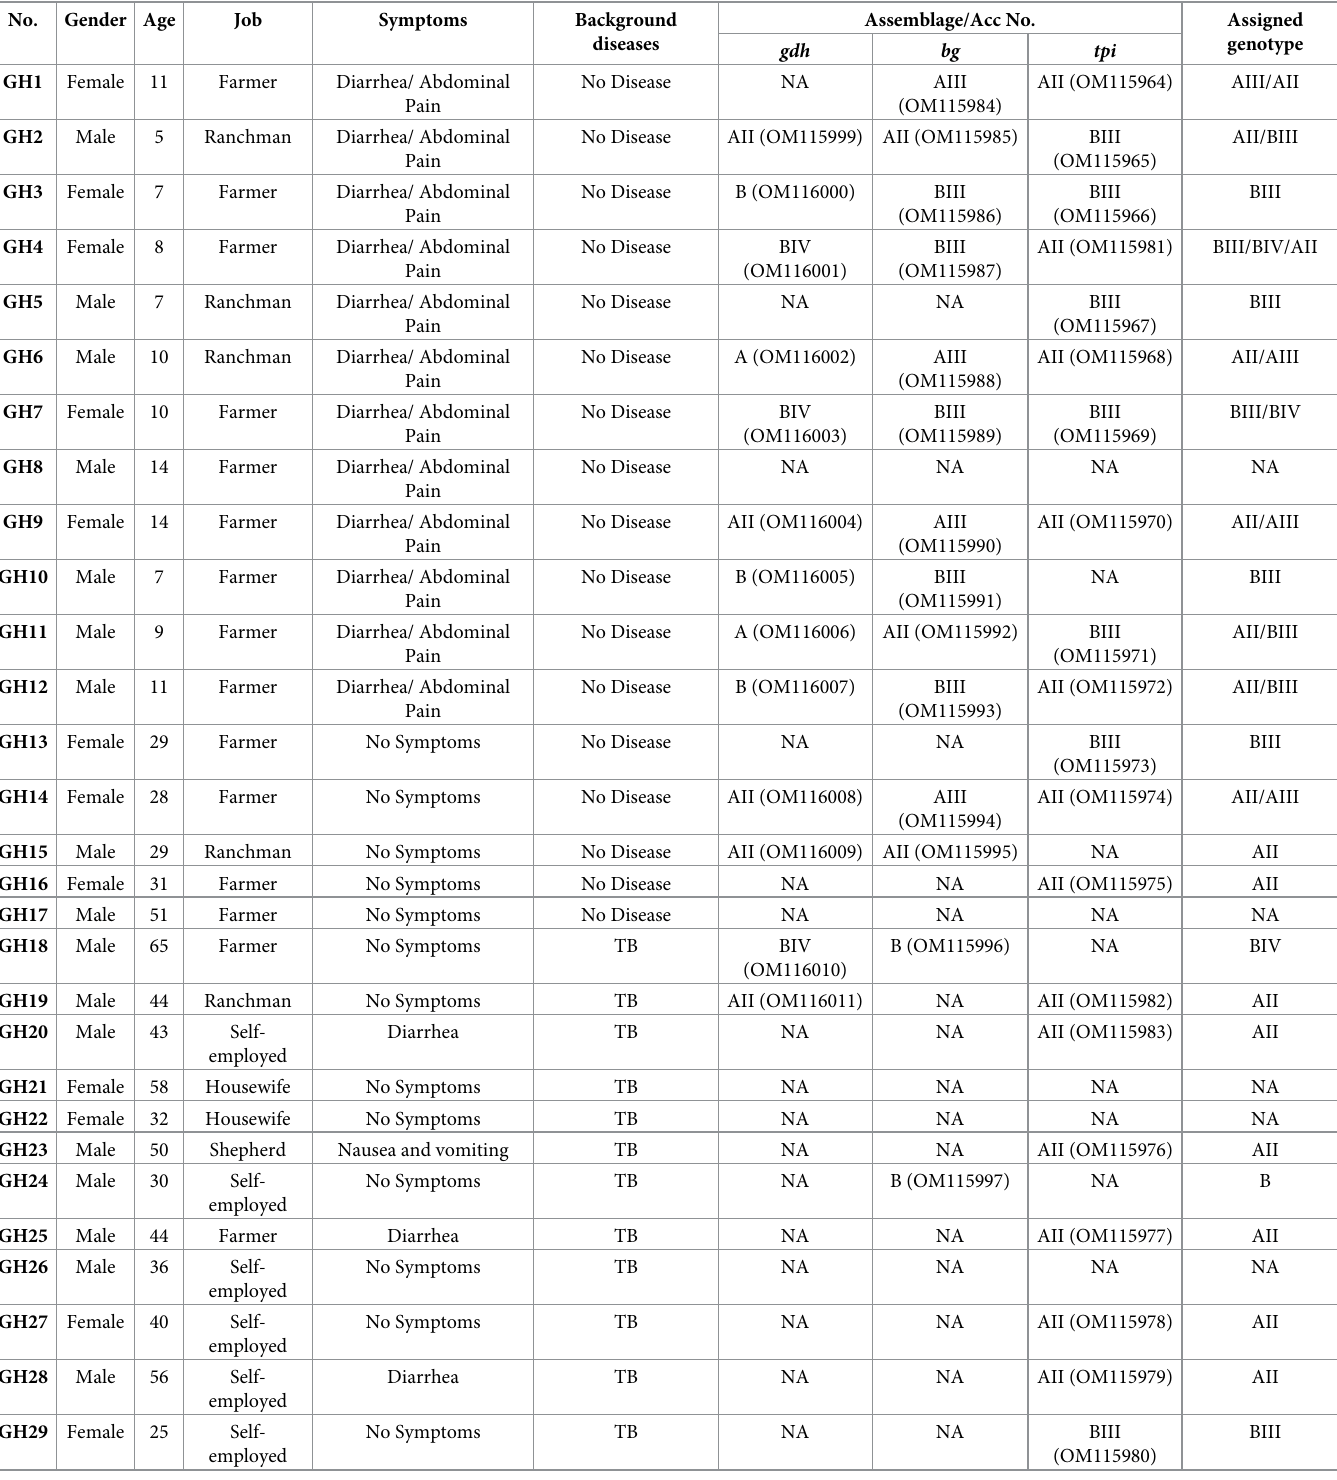
Table 4. Demographic characteristics and clinical symptoms of TB patients and non-TB group, G . duodenalis -positive isolates, and the relevant genotypes.